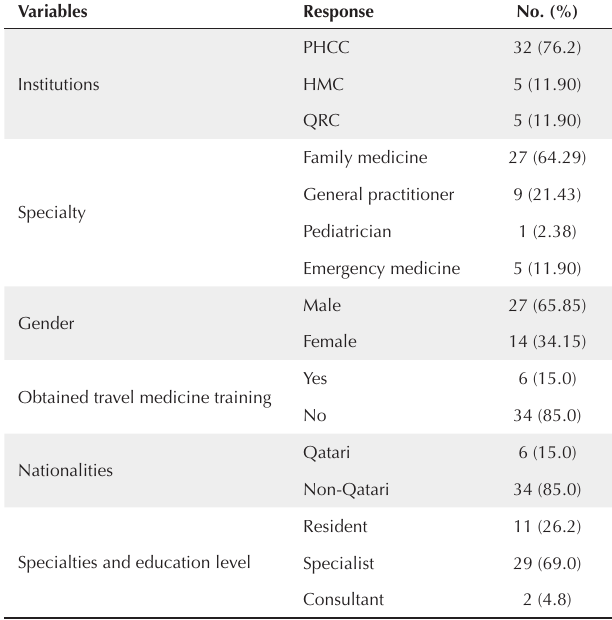
Table 1. Demographic Profile of the Study Population in the State of Qatar